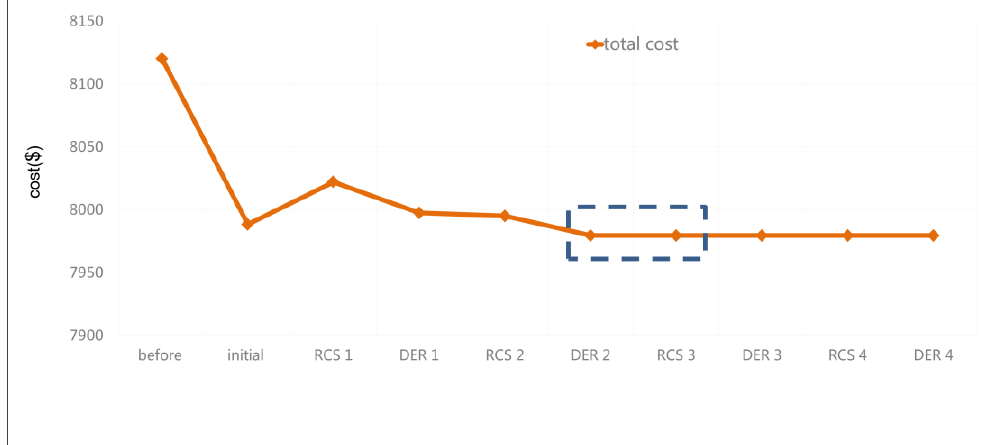
Figure 10. Results during iterations in Case